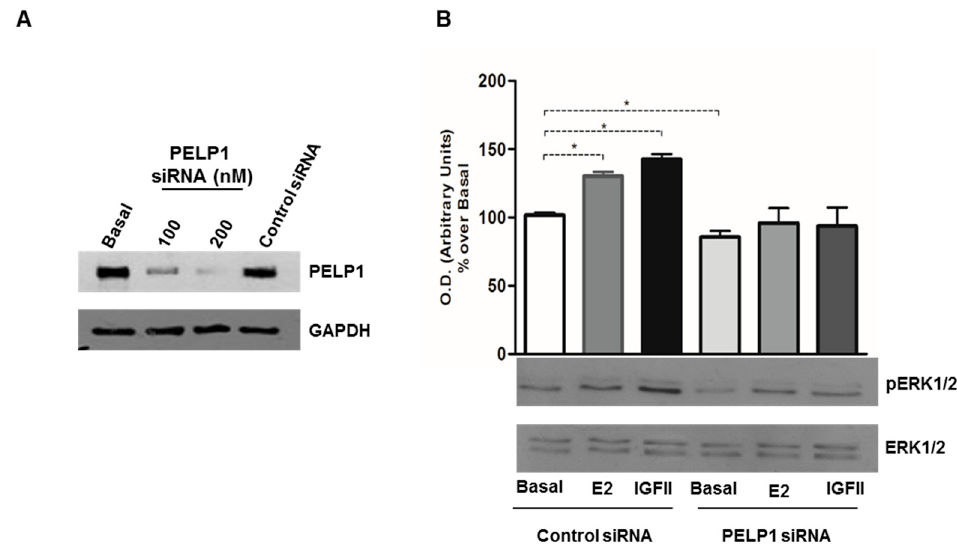
Figure 3. PELP1 knockdown decreases ERK1/2 phosphorylation. ( A ) H295R cells were transfected with PELP1 siRNA (100 nM and 200 nM) or a non-targeting siRNA (control siRNA) for 24 h. Western blot analyses of PELP1 were performed on 50 µ g of total protein; ( B ) H295R cells were transfected with control siRNA or PELP1 siRNA. After 24 h cells were treated for 10 min with E2 (100 nM) or IGF-II (100 ng/mL). Western blot analyses of PELP1 were performed on 10 µ g of total protein. Results are representative of three independent experiments. GAPDH and ERK1/2 were used as a loading control; upper panel graph represents mean of pERK1/2 optical density (O.D.) from three independent experiments with similar results normalized to ERK1/2 content (* p < 0.001 compared to untreated control sample (basal) assumed as 100).